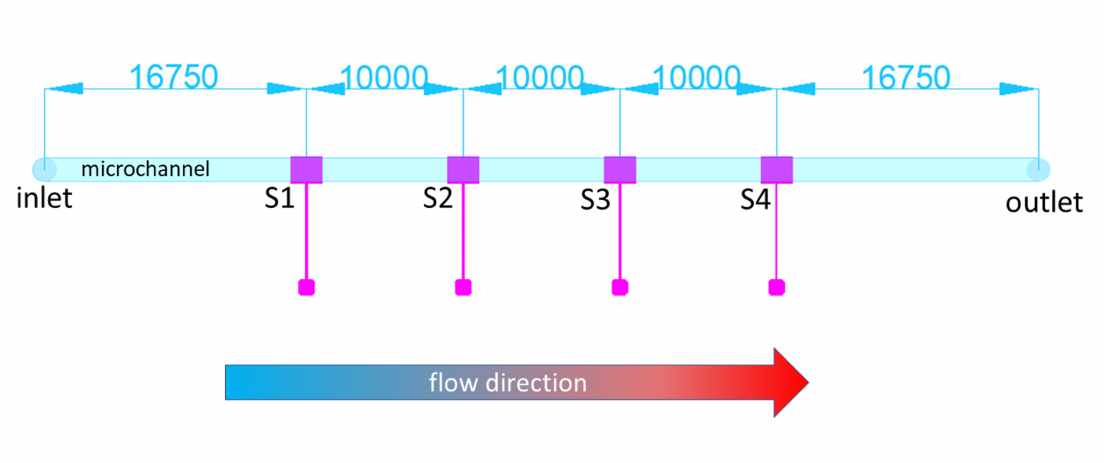
Figure 13. Location of the sensors center with respect to the channel inlet center located along the channel.